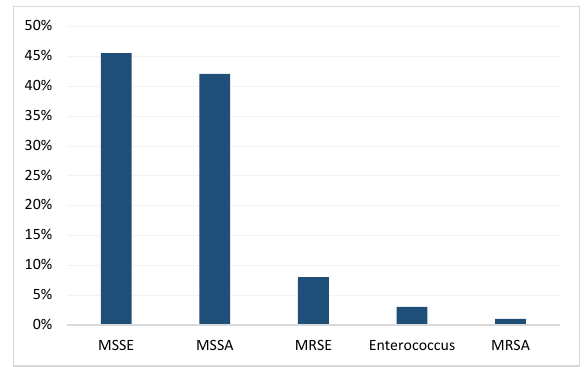
Figure 3 . Prevalence of various organisms in people with catheter infection with gram-positive bacteria. MSSE, methicillin sensitive Staphylococcus epidermidis ; MSSA, methicillin sensitive Staphylococcus aureus ; MRSE, methicillin-resistant Staphylococcus epidermidis ; MRSA, methicillin-resistant Staphylococcus aureus.